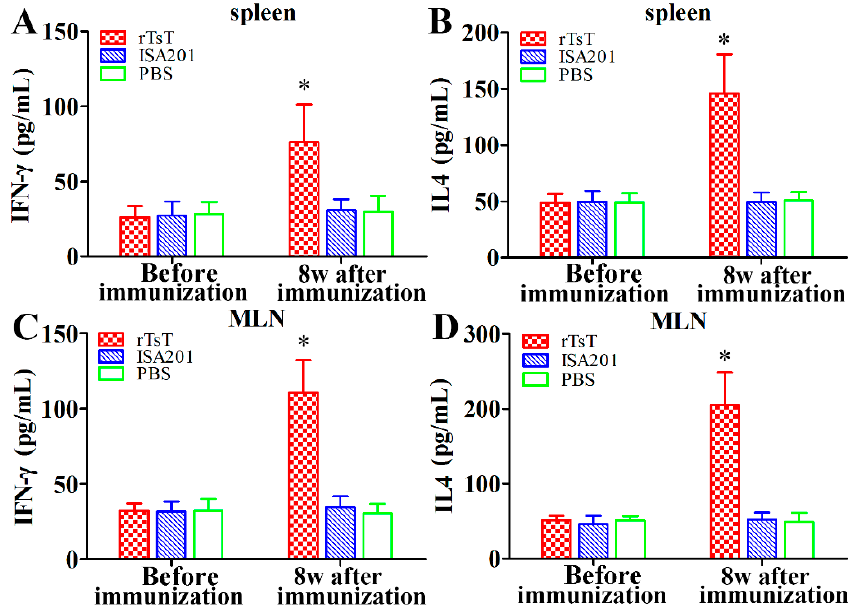
Figure 11. Cytokines secreted by spleen ( A , B ) and MLN ( C , D ) cells on rTsT stimulation. The assay of the cytokine IFN- γ and IL-4 was performed on the cells stimulated for 72 h with rTsT. The data are the mean ± SD of cytokine levels for 5 mice per group. * Significantly different with respect to the ISA 201 or PBS control group (* p < 0.01).